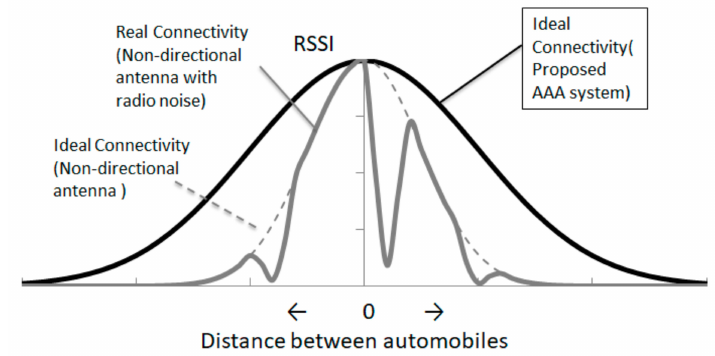
Figure 2. Target connectivity of the proposed